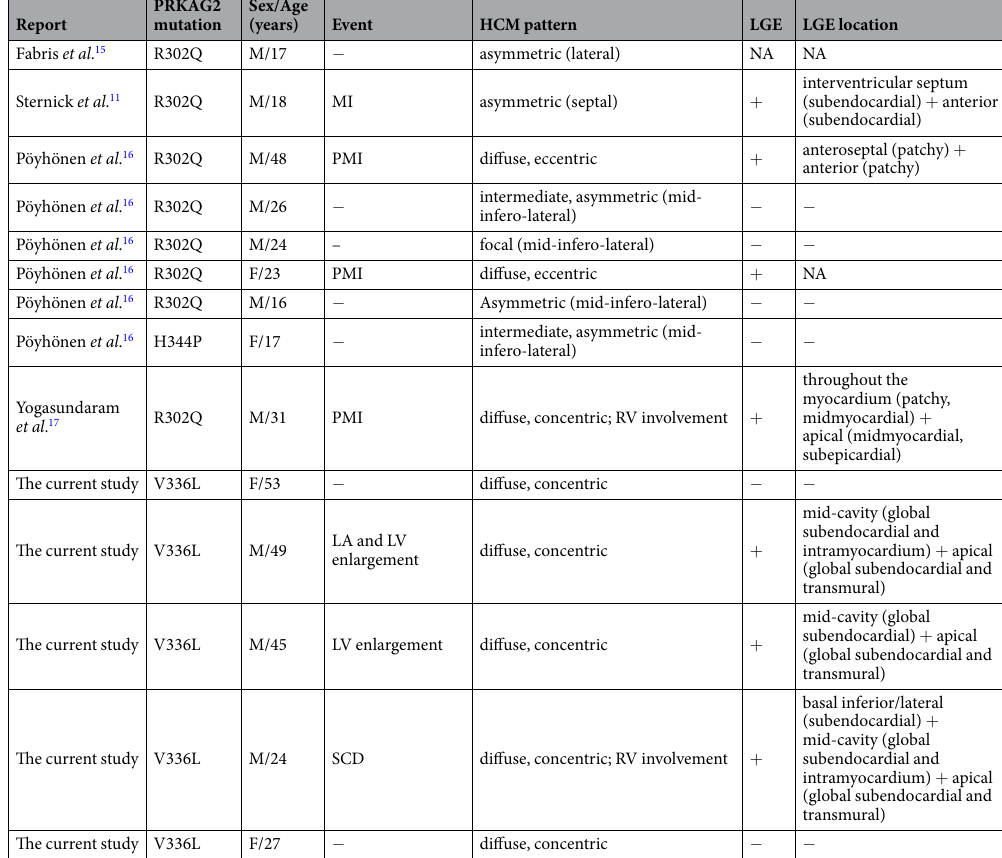
Table 3. CMR features of patients with PRKAG2 syndrome. M, male; F, female; LA, left atrium; LV, left ventricle; RV, right ventricle; NA, not available; MI, myocardium infarction; SCD, sudden cardiac death; PMI, pacemaker